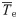
Release kinetics and resulting cost function scores and normalized concentration distributions for repesentative designs of quasi-bolus, first-order, and zero-order drug release.
A: Release profiles as quantified by the time evolution of the remaining mass percentage of drug in the polymer coating (RMC). B Time evolution of the endothelial toxicity score T¯e (left y-axis) and the inefficacy score I¯m (right y-axis). C: Contour plots of the concentration distribution normalized by the minimum efficacious concentration c
eff at 1 hour (first row), 1 day (second row) and 1 week (third row) post stent implantation. The highest concentration values encountered close to the stent strut surface are colored in black indicating toxic concentrations. A green contour line marks the threshold between efficacious and non-efficacious drug concentration in the media. If the contour is missing, the entire depicted domain is exposed to efficiacious concentrations. The red countour lines enclose toxic concentration regions in the media and mark concentration levels at the endothelial surface that are unacceptably elevated.